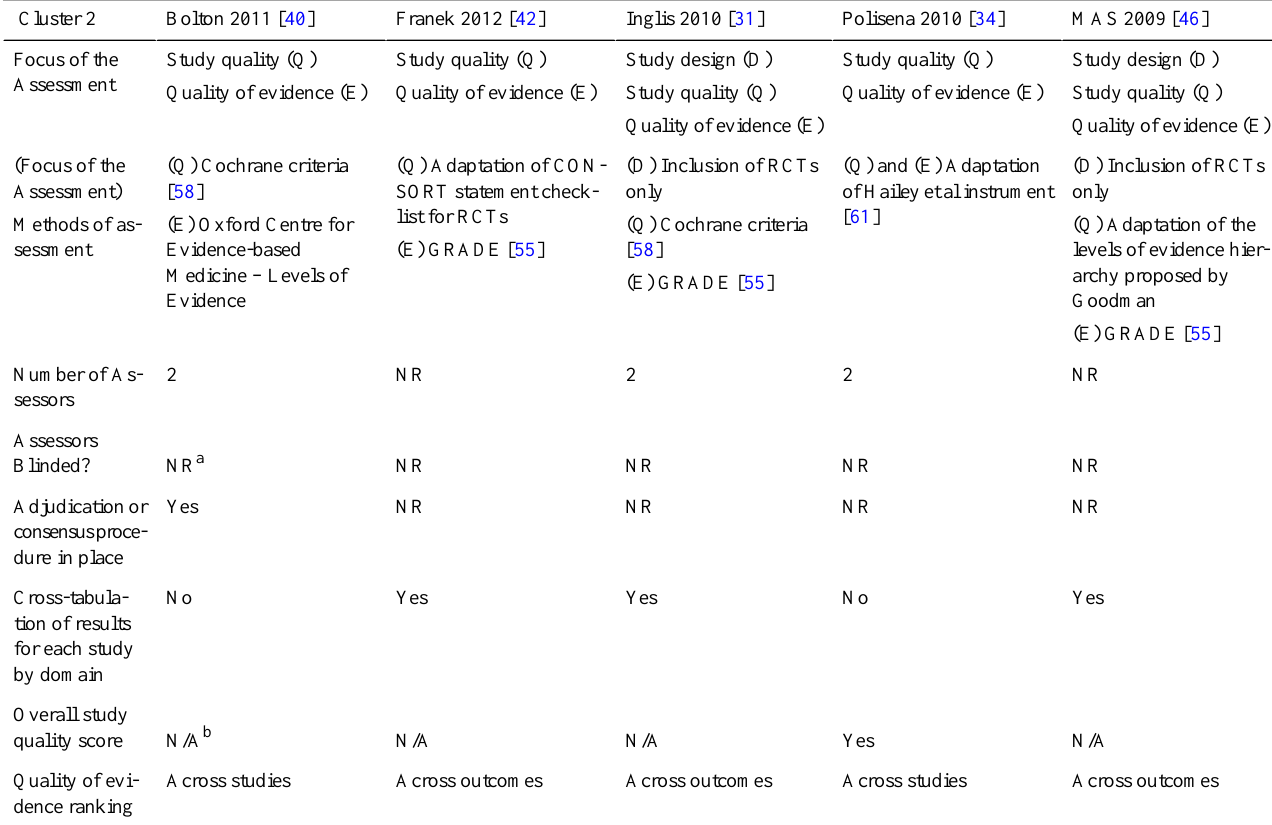
Table 4. Methods and instruments used for the quality assessment of the primary studies—Cluster